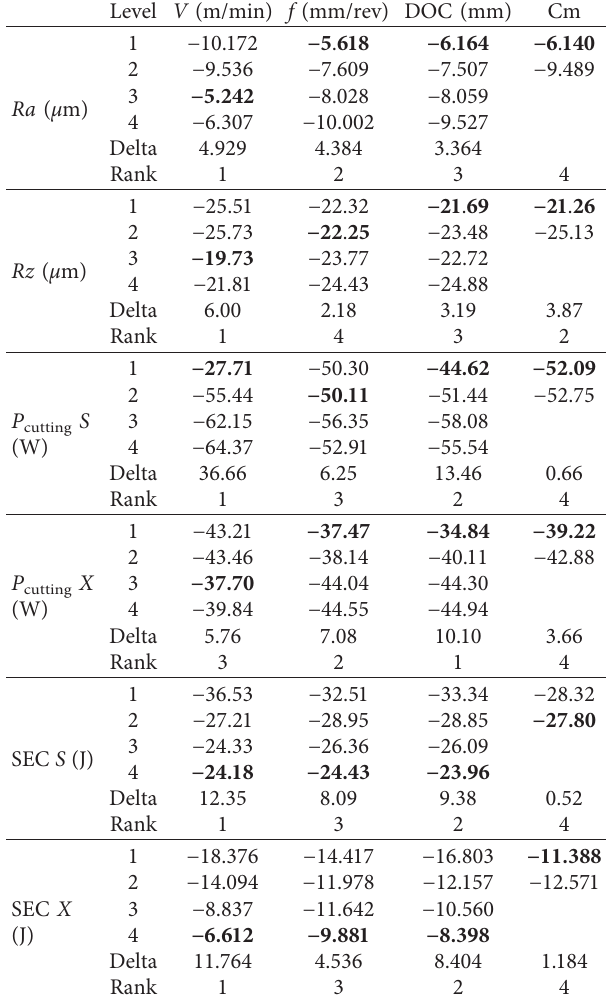
Table 6: S/N response table for surface roughness and energy